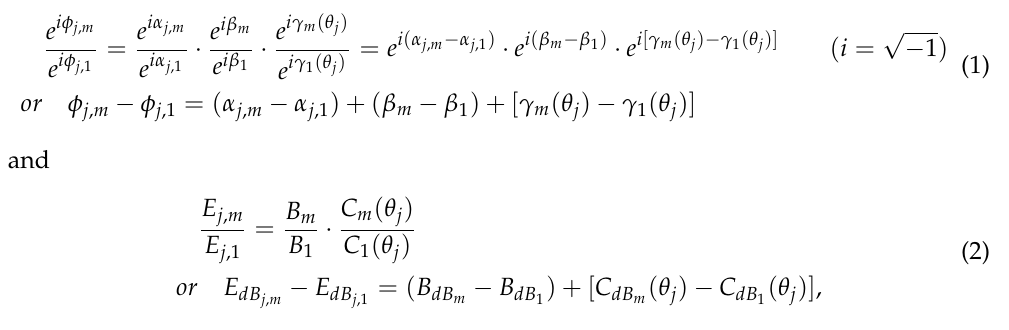
Figure 8. Measured phase relative to Ant. 1: ( a ) at 26 ◦ (DOA bearing of 19 ◦ ) and ( b ) at − 35 ◦ (DOA bearing of − 42 ◦ ); measured amplitude relative to Ant. 1: ( c ) at 26 ◦ (some distorted values are removed) and ( d ) at − 35 ◦